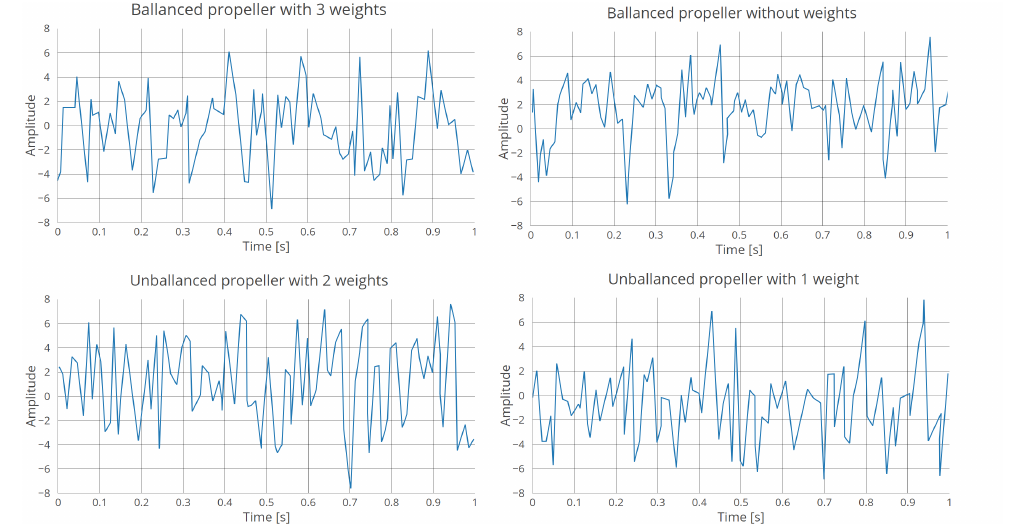
Figure 8. One-second-long raw data